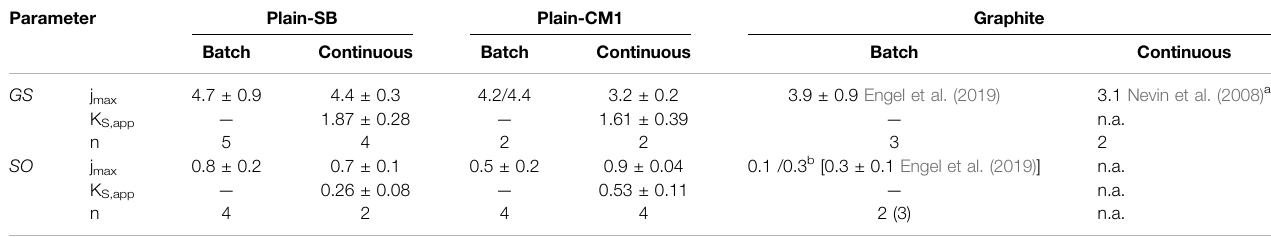
TABLE 2 | Maximum current densities j max [A/m 2 ] and apparent half-saturation constants K S,app [mM] for G. sulfurreducens and S. oneidensis in batch and continuously operated plate reactors with woven CF electrodes. Parameter Plain-SB